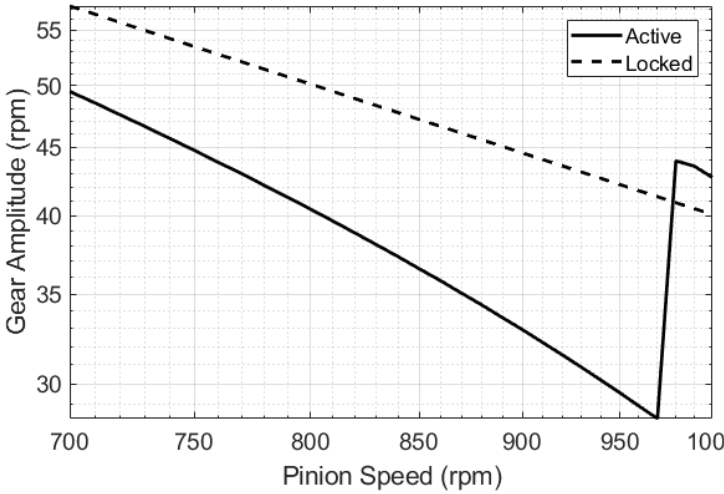
Figure 2. ( a ) NNMs without the rigid body mode and using the average meshing stiffness; ( b ) zoom- in for the first mode in the experimentally observed frequency range. Figure 3. Numerical frequency response curve for 𝑘 𝑁 = 430 Nm/rad 3 .